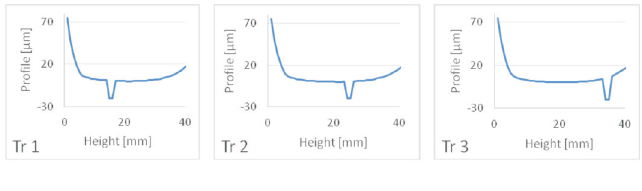
Fig. 3. Tr1, Tr2, Tr3 variants of the piston bearing surface profile Rys. 3. Profile tłoków Tr1, Tr2, Tr3